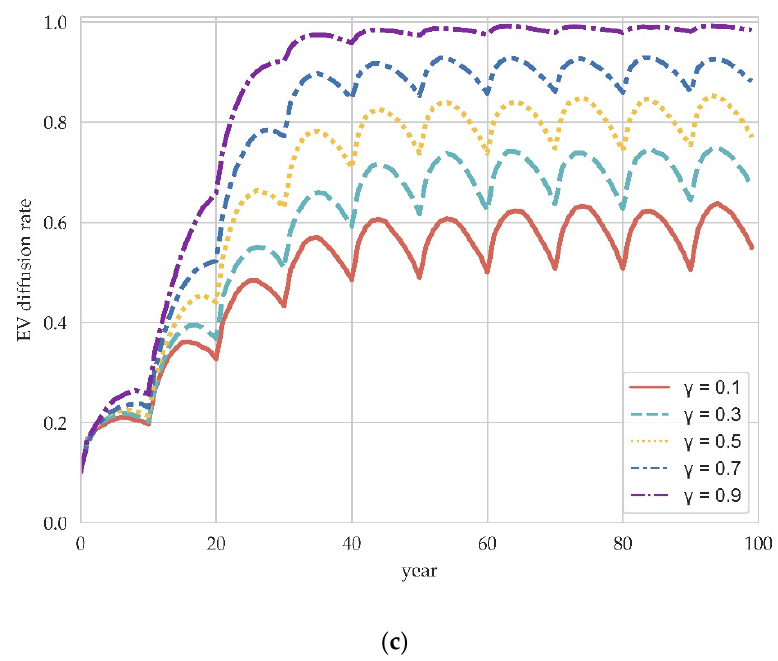
Figure 6. The impact of information policy on EV diffusion in different scale network. ( a ) 𝑀 = 100 . ( b ) 𝑀 = 200 . ( c ) 𝑀 = 300 .